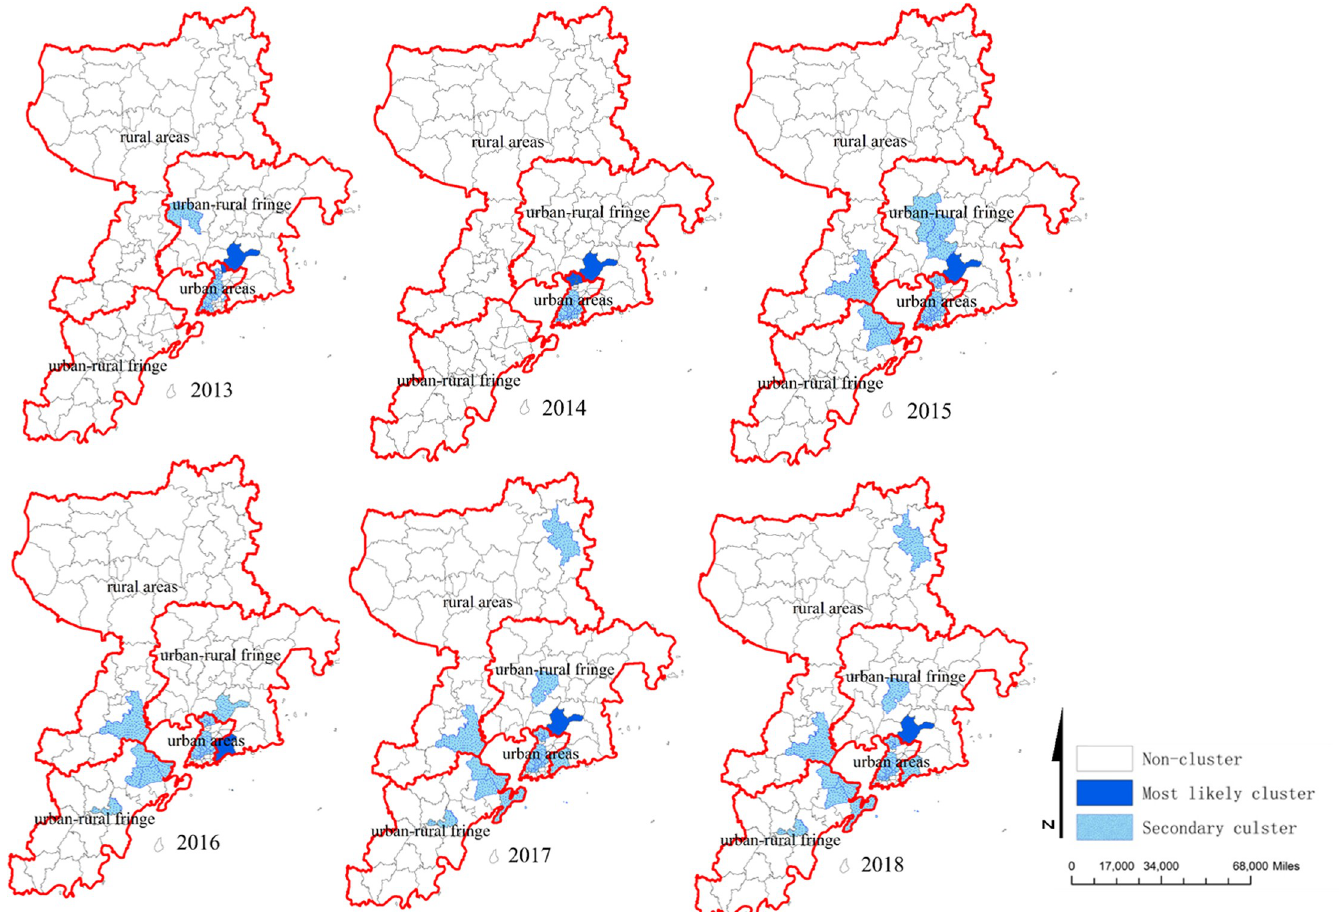
Fig 3. Spatial clusters of HFMD in Qingdao City,